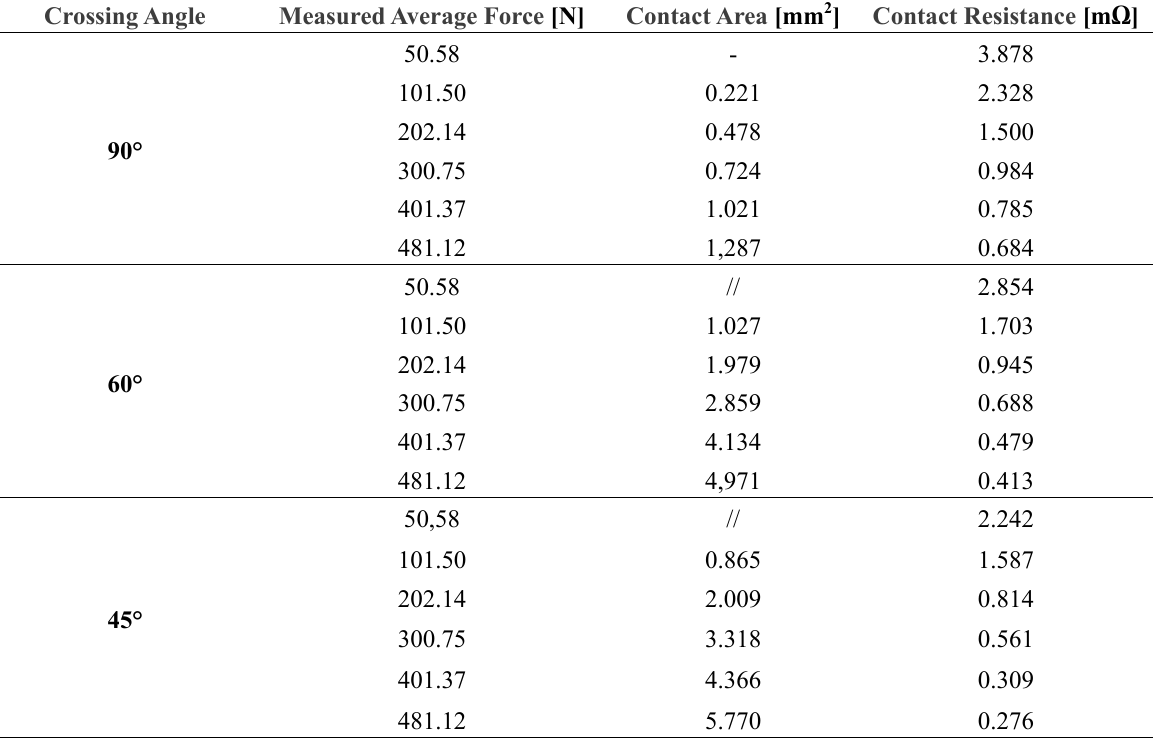
Table 1. Measurement of the electrical contact resistance (mΩ) as a function of the applied force (N) and the dimension of the contact area (mm 2 ) measured for crossing angles 90°, 60° and 45°, for the wire of 1.80 mm